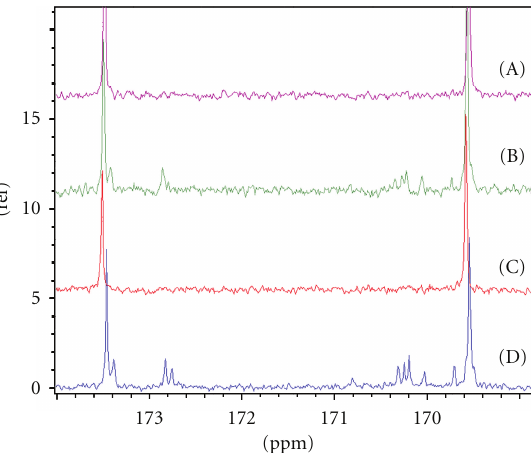
Figure 1: SEC analysis of central PLA block 40 kDa (B) and final triblock copolymer PCL-PLA-PCL 20-40-20 kDa (A). Figure 2: Dyads and triads area of 13 C NMR analysis of polymers presented in Table 3: (A) polymer 1, (B) polymer 3, (C) polymer 4, (D) polymer number